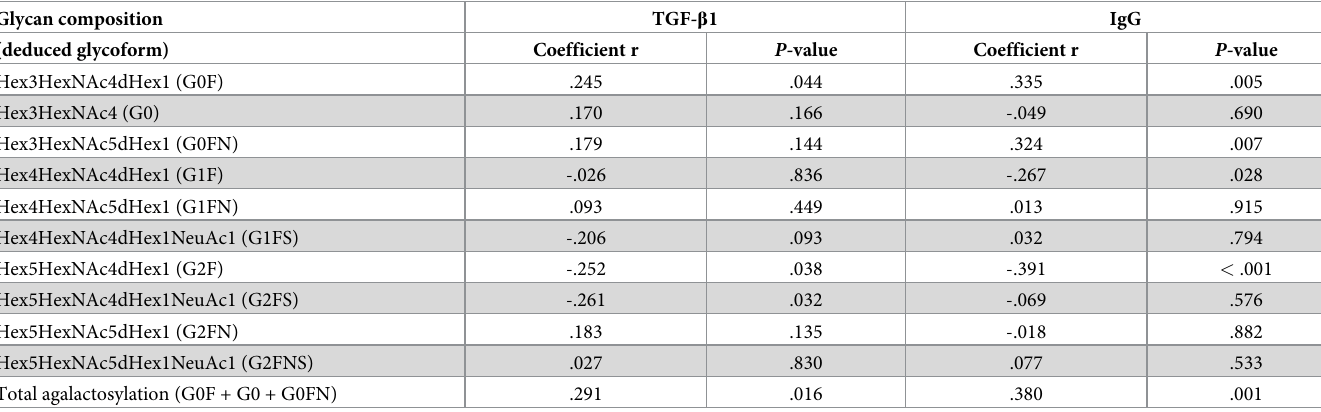
TGF- β 1 after telbivudine treatment is the net result that comes from a delicate balance between pharmacology and immunomodulation. It is very likely that other cell lineages or complex reg- ulatory networks may involve in telbivudine-dependent TGF- β 1 upregulation in vivo . TGF- β 1 is a notoriously liver fibrogenic factor that activates quiescent hepatic stellate cells to produce and accumulate extracellular matrix proteins in the liver tissues [17–19]. Apart from TGF- β 1, an accumulation of immune complexes by a plethora of IgG antibodies tends to induce hepatic fibrosis as well [20, 21]. Accordingly, it is rational to speculate that TGF- β 1 and IgG form a vicious circle for the progression of liver fibrosis. From a clinical aspect, long-term follow-ups for TGF- β 1 kinetics in addition to HBV virology and liver histology would be of great Table 5. Correlations of changes in levels of serum IgG 1 -Fc N -glycoforms and TGF- β 1 or IgG in cirrhotic patients (n = 68) during treatment. Glycan composition TGF- β 1 (deduced glycoform) .690 .179 .144 .324